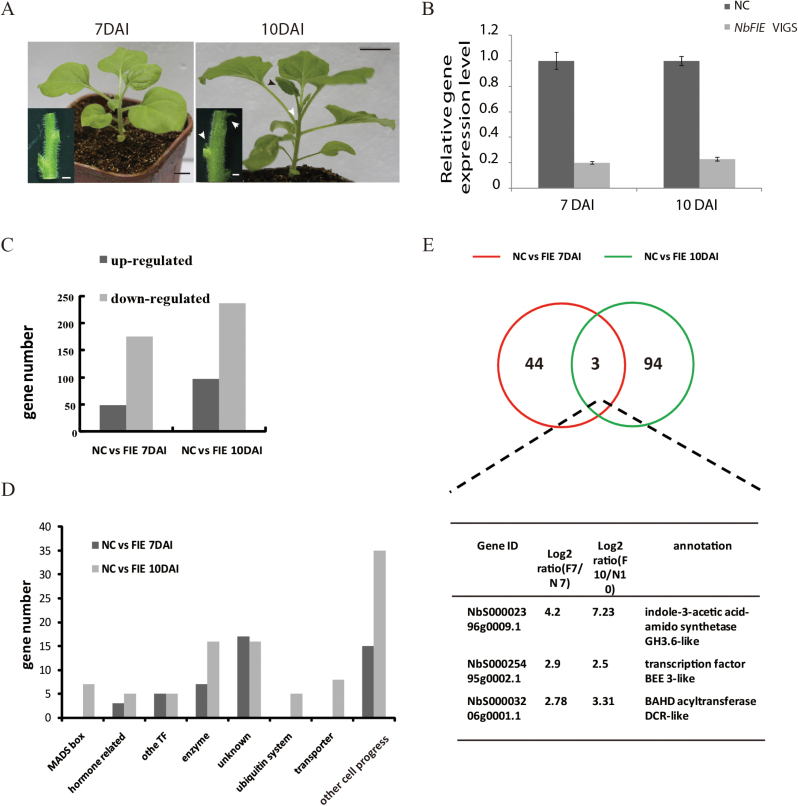
RNA-seq analysis at 7 and 10 DAI. (A) Representative NbFIE-silenced plant at 7 and 10 DAI. Inlets, dissected stems to show axillary buds. White arrowheads indicated sprouted axillary buds; the black arrowhead showed the wrinkle of leaf margin. (B) The expression level of NbFIE genes in NbFIE-silenced plants at 7 and 10 DAI. Error bars indicate standard deviation calculated from three technical repeats. (C) The number of up-regulated and down-regulated genes (log2 ratio>2, and P-value<0.01) in NbFIE-silenced genes at 7 and 10 DAI. (D) Function categories of up-regulated genes in NbFIE-silenced genes at 7 and 10 DAI. (E) Overlapped up-regulated genes at 7 and 10 DAI. Bars (black) in (A), 1cm. Bars (white) in inlets of (A), 1mm.